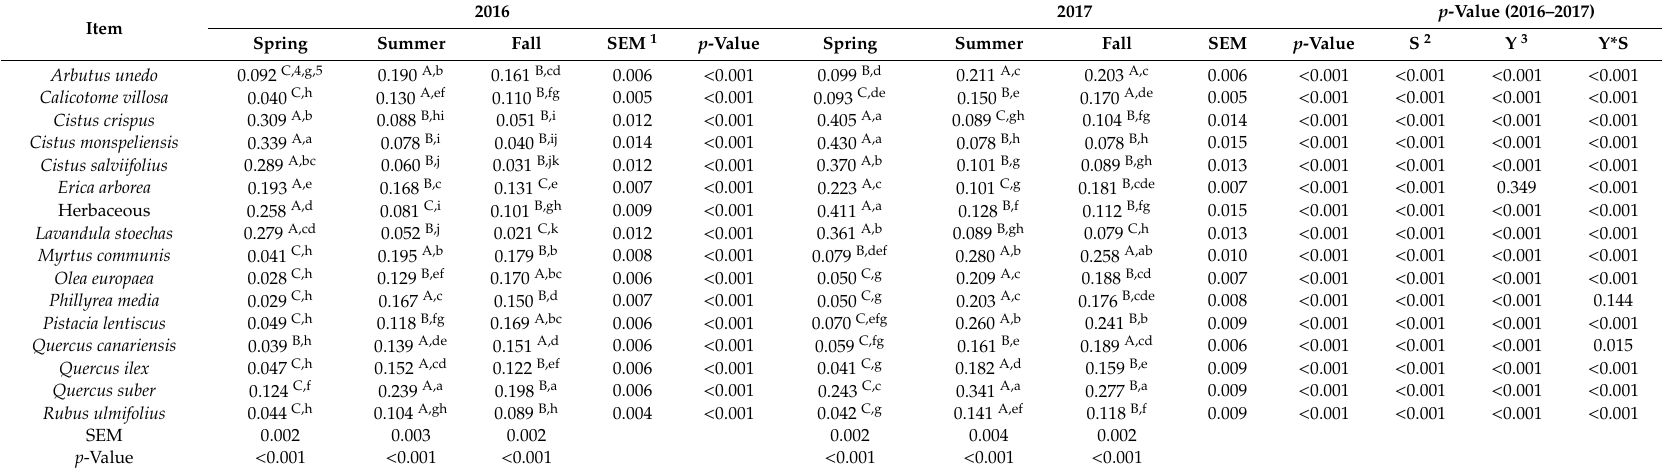
Table 2. Bite mass (g DM) of plant species consumed by goats browsing a Southern Mediterranean forest rangeland during 2016 and